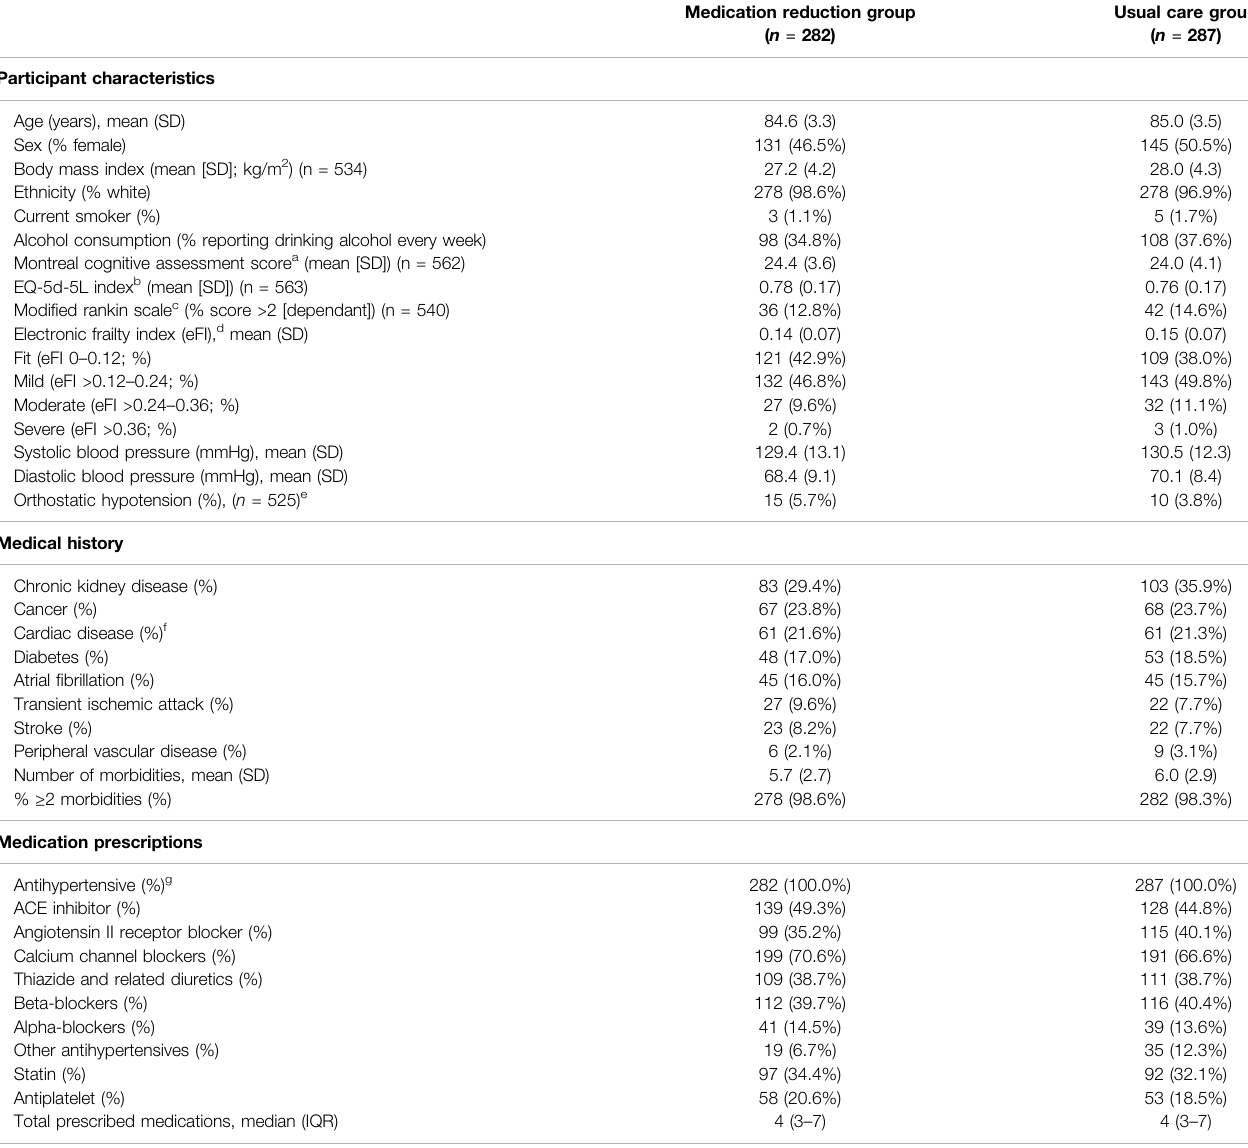
TABLE 1 | Baseline demographics and clinical